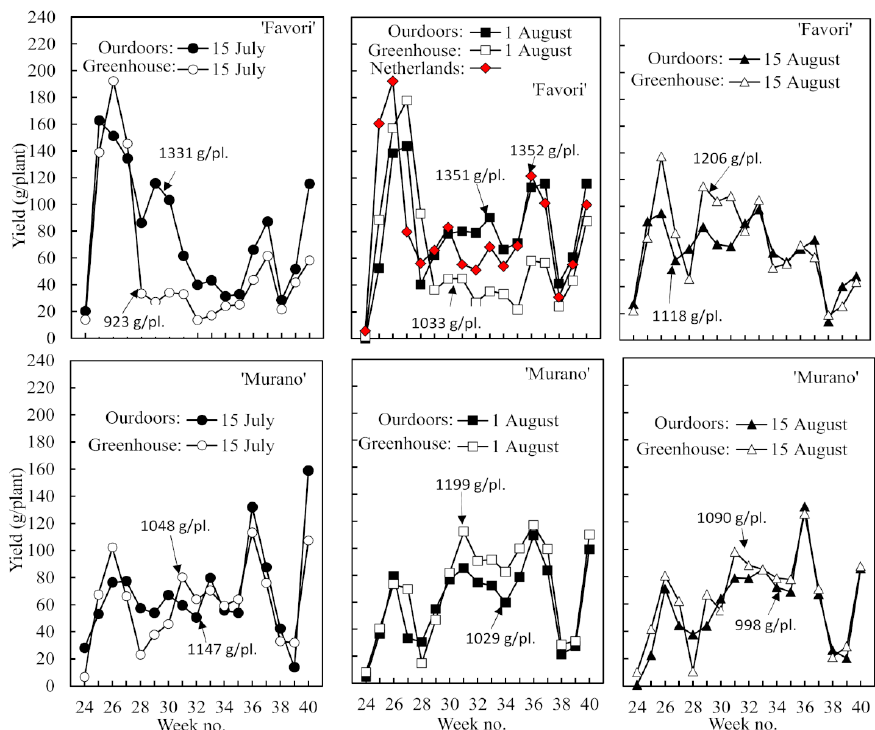
Figure 4. Time courses of berry yield per harvest in ‘Favori’ (above) and ‘Murano’ strawberry as affected by rooting date and raising environment as indicated and subsequent cropping in a plastic tunnel in the following year. Results for imported ’Favori’ plants included for rooting date 1 August. The data are means of three replicates with nine plants of each cultivar.